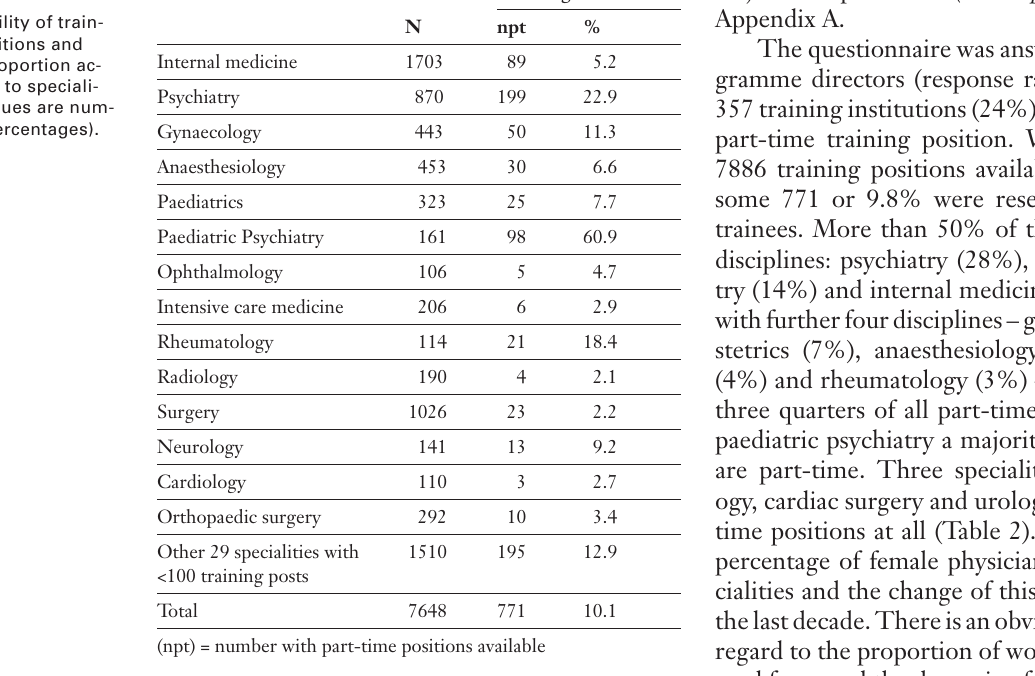
major sub-specialities (Schwerpunkte) is shown in